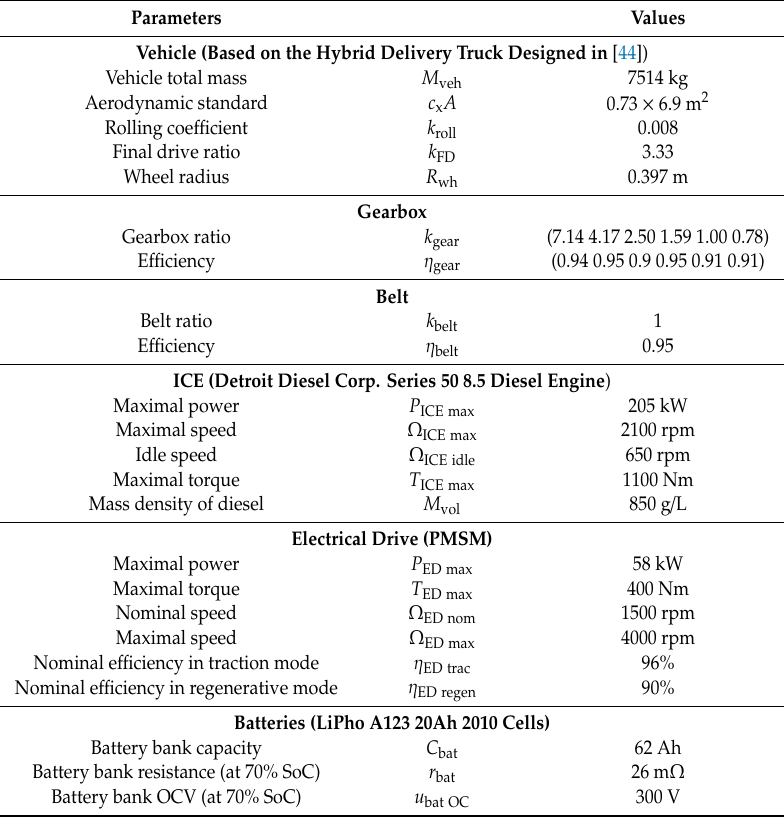
Table 1. Examined system parameters for simulation of the parallel hybrid